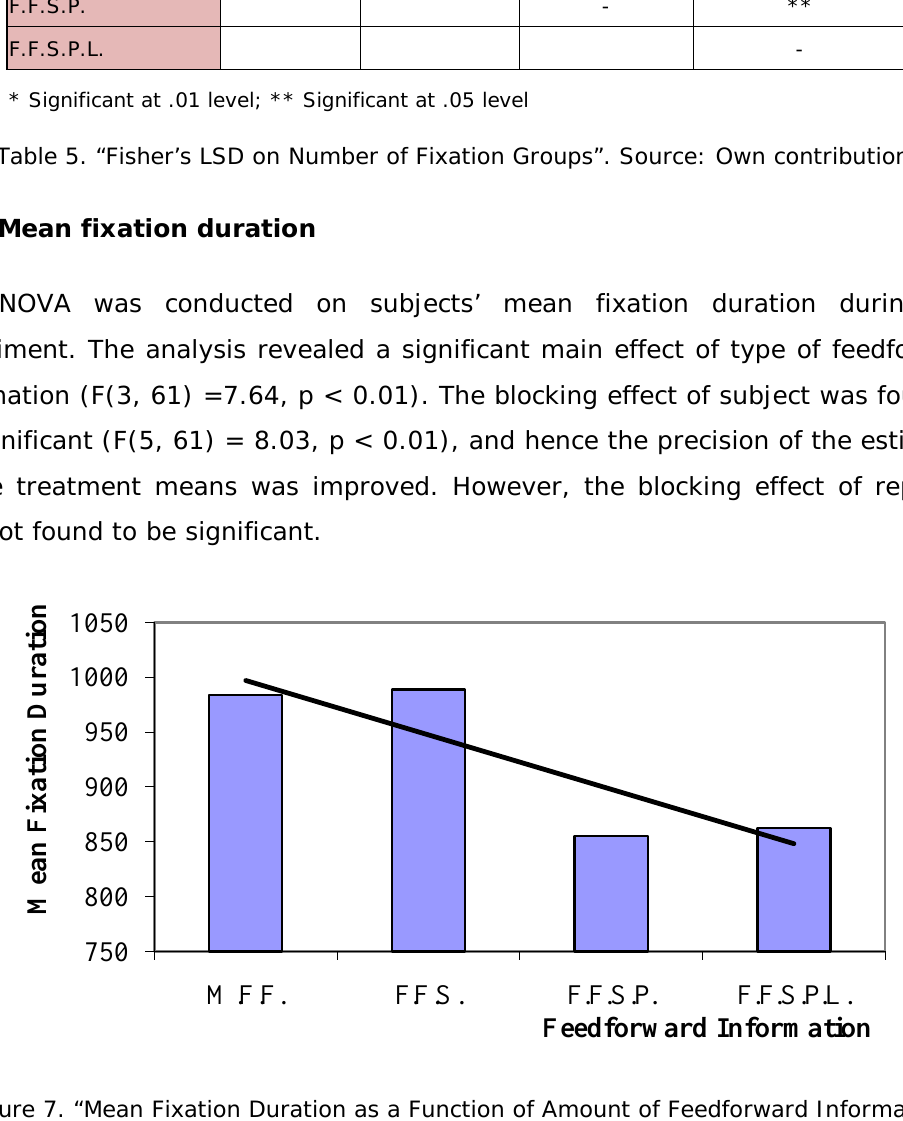
Figure 7. “Mean Fixation Duration as a Function of Amount of Feedforward Information Provided”. Source:Own